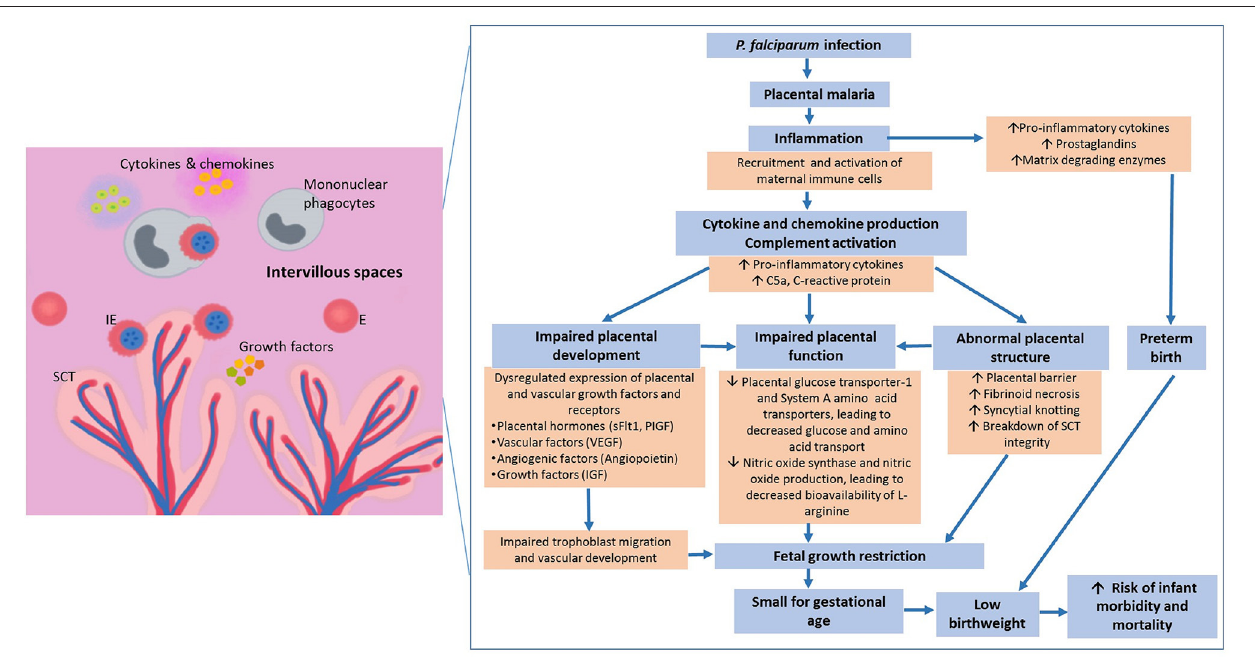
FIGURE 1 | Pathways leading to malaria in pregnancy-associated low birthweight. Infected erythrocytes express unique variant surface antigens that mediate binding to placental receptors. Sequestration leads to recruitment and activation of different immune cells that can result in a cascade of downstream inflammatory events. These inflammatory events include secretion of cytokines and chemokines that have been associated with poor pregnancy outcomes. The increased pro-inflammatory environment has been associated with – (1) dysregulated expression of growth hormones, vascular factors and angiopoietin-1 and -2; (2) abnormal placental development; and (3) reduced placental nutrient transport, overall contributing to placental insufficiency. Together, these factors contribute to malaria in pregnancy associated low birthweight which is the biggest predictor of infant morbidity and mortality globally and annually., ↑ , increase; ↓ , decrease; E, Erythrocytes; IE, Infected erythrocytes; SCT, Syncytiotrophoblast; IVS, Intervillous space; sFlt1, soluble fms-like tyrosine kinase-1; PIGF, Phosphatidylinositol-glycan biosynthesis class F protein; VEGF, Vascular endothelial growth factor; IGF, Insulin-like growth